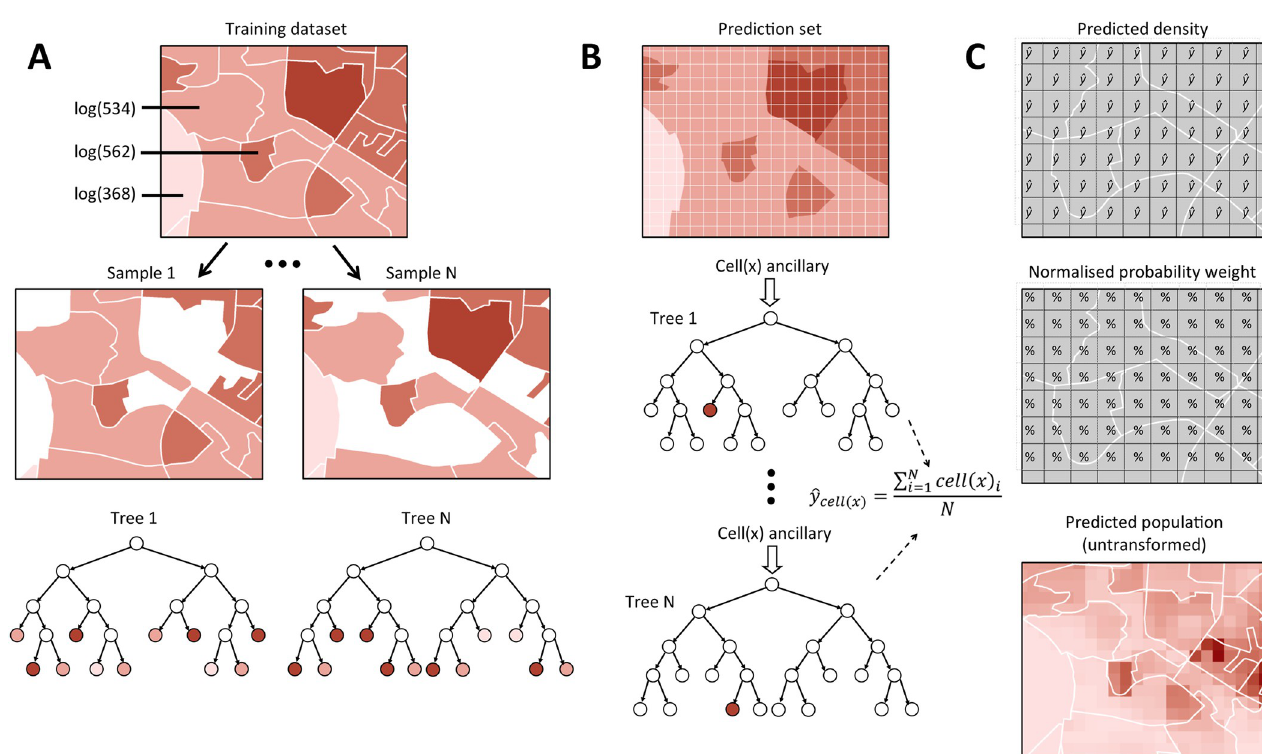
Fig 5. Overview of WorldPop-Global random forest modelling workflow. (A) Each decision tree in the ensemble is built upon a random bootstrap sample of the log-transformed population and ancillary data by administrative unit. (B) Population density prediction for each cell y cell(x) is based on an average of the individual trees. (C) Predicted cell densities are normalized by administrative unit and used to dasymetrically disaggregate log-transformed administrative unit population, then transformed to predict population per cell.